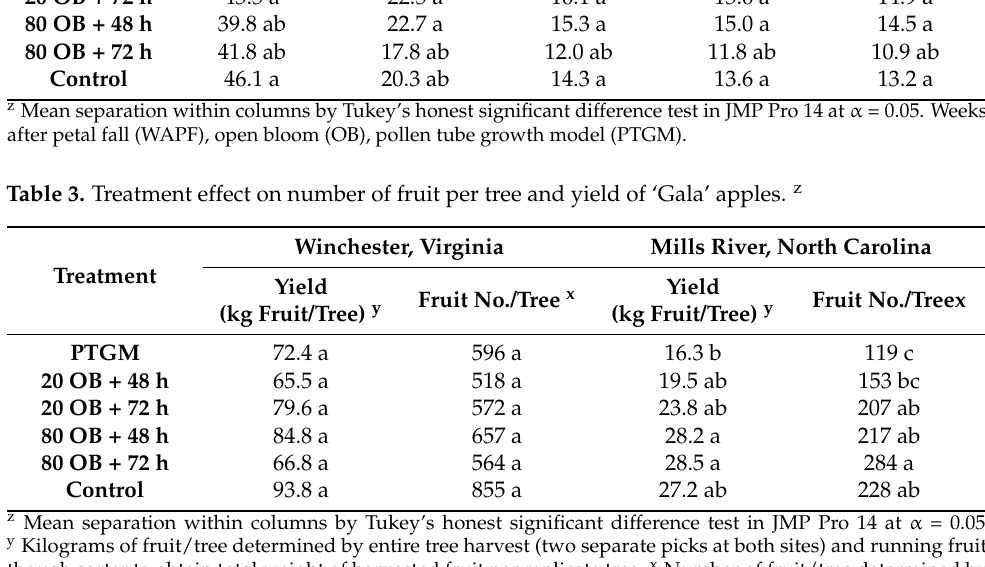
Table 3. Treatment effect on number of fruit per tree and yield of ‘Gala’ apples. z